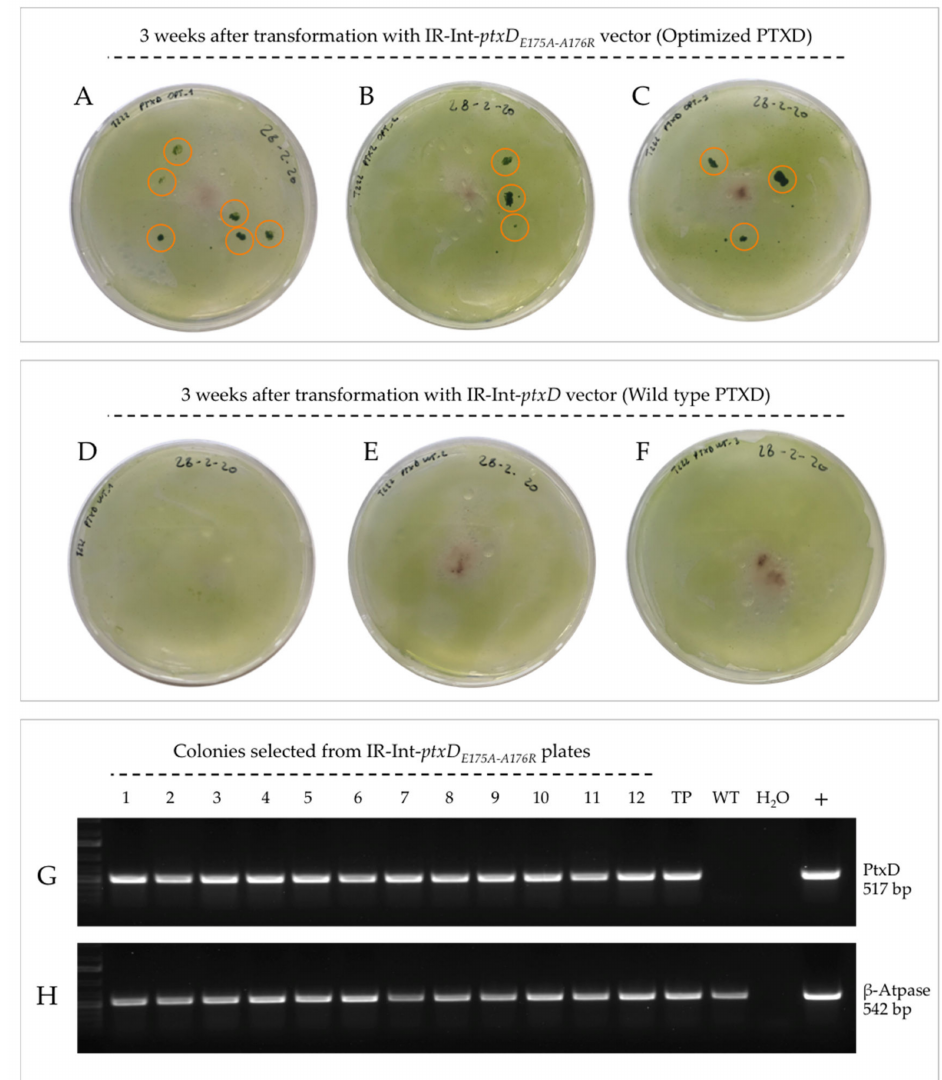
Figure 6. PTXD-based genetic transformation of the chloroplast genome coupled to phosphite metabolism-based selection. One-week phosphorous-starved T222 wild type cells were transformed with the IR-int vectors carrying the two PTXD versions. After 3 weeks, a number of colonies were clearly distinguishable on independent transformation plates for the Int- ptxD E175A-A176R vector (panel A , B and C , orange circled). No colonies could be retrieved following transformation with the wild type enzyme version (panel D , E and F ). True transformation events were confirmed for all selected colonies via PCR-based genetic analysis on genomic DNA targeting the PTXD transgene (1-12, panel G ). A positive reaction against the plastid ATP-ase β subunit gene was included (panel H ). TP refers to characterized transplastomic PTXD lines produced in this work; WT is the untransformed T222 wild type